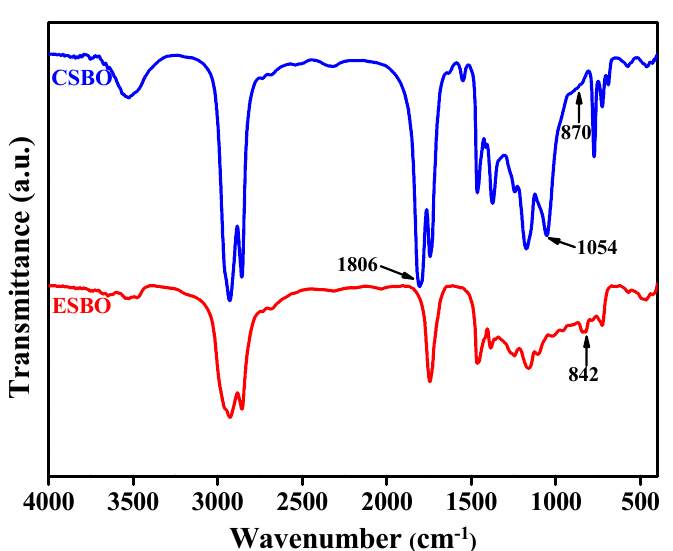
Figure 3. FTIR Spectra of ESBO and CSBO.